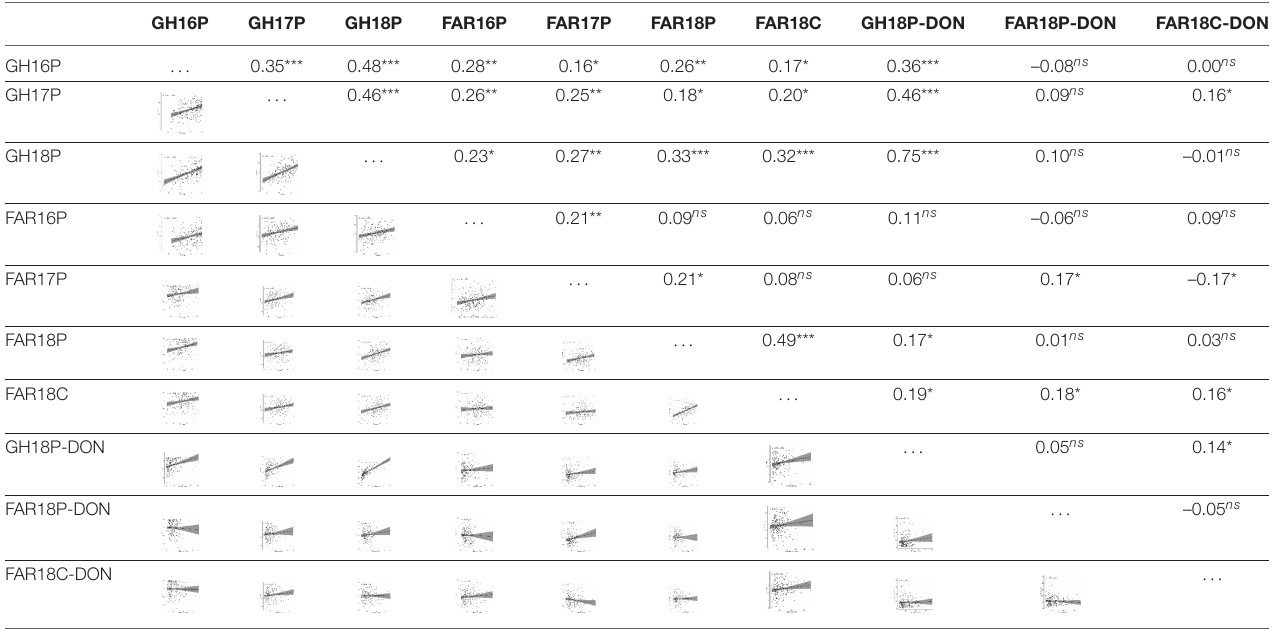
TABLE 3 | Spearman’s correlation coefficient between FHB disease severity (proportion of symptomatic spikelets) and deoxynivalenol (DON) levels calculated from individual experiments. GH16P GH17P GH18P FAR16P